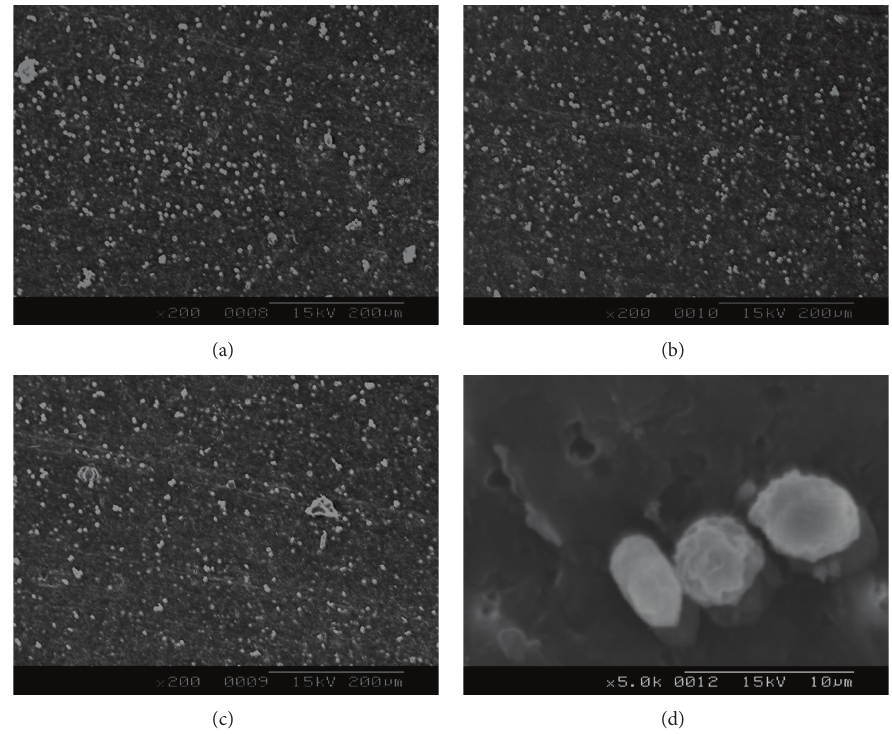
Figure 7: SEM micrographs showing the cell growth over the surface of blend samples with microporosity on